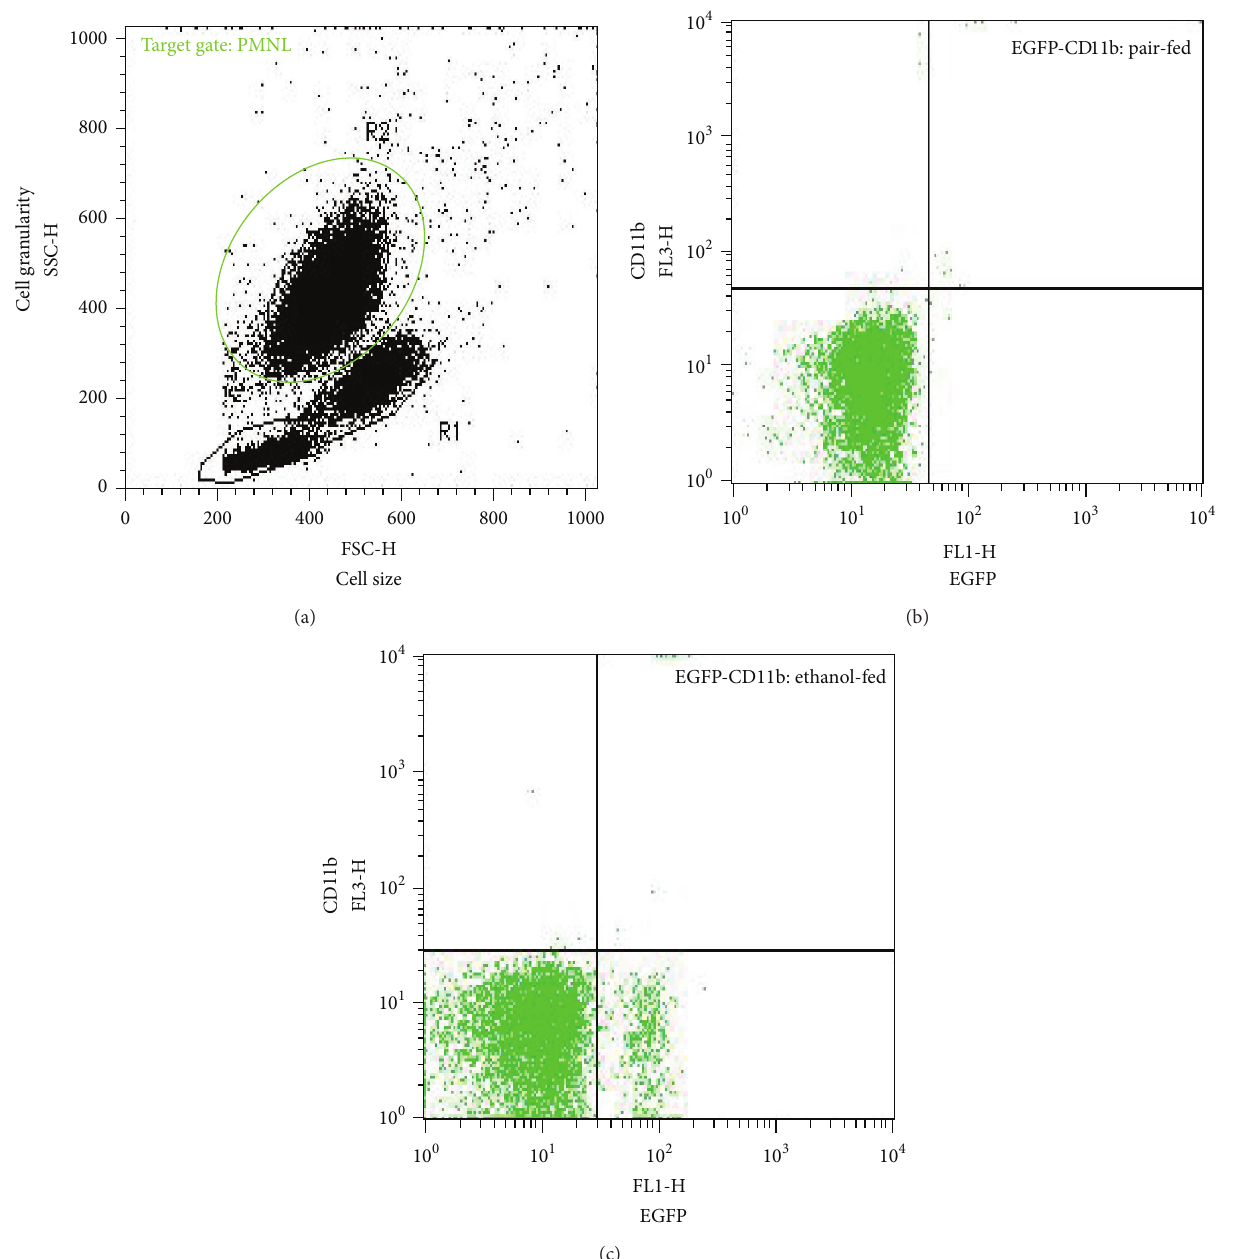
Figure 1: Gating strategy for the determination of PMNL. Representative FACS diagrams are shown. In (a), blood samples, obtained from cis -NF- 𝜅 B EGFP after feeding Lieber-DeCarli diet for 4 weeks, were analyzed and the region (R2) was set according to the forward/side scatter characteristics (FSC/SSC) of PMNL. Dot plots depict EGFP expression versus isotype control CD11b staining from (b) pair- and (c) ethanol- fed